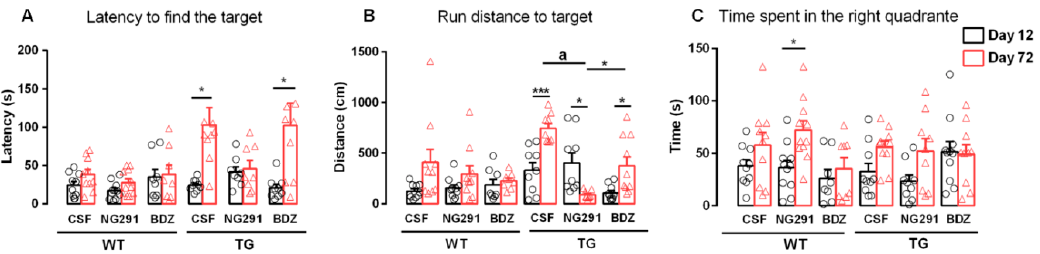
Figure 1. Effect of BK analogues treatment on spatial memory. Spatial memory was evaluated using the Barnes maze test with the time taken to enter the escape box being recorded. Data show that kinin B2R agonist NG291 treatment prevented the memory impairment observed in vehicle and B2R antagonist treated transgenic mice. WT—C57Bl/6 non-transgenic littermate mice; TG—B6.Cg-Tg (PDGFB-APPSwInd) transgenic mice; CSF—Artificial cerebral spinal fluid; NG291—B2R agonist; BDZ—B2R antagonist bradyzide. WTCSF ( n ) = 10, WTNG291 ( n ) = 11, WTBDZ ( n ) = 8, TGCSF ( n ) = 9, TGNG291 ( n ) = 8, TGBDZ ( n ) = 9, Histograms and vertical bars are means ± SEM. Data were analyzed